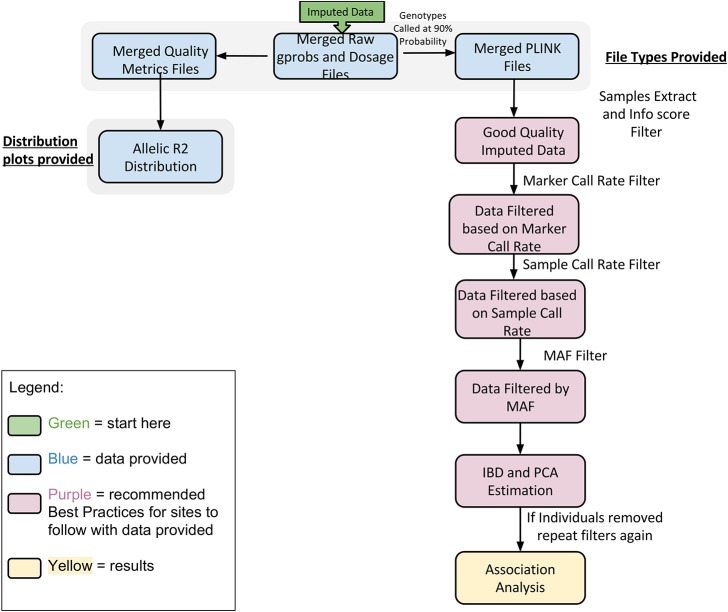
Best practices for analyzing imputed data.